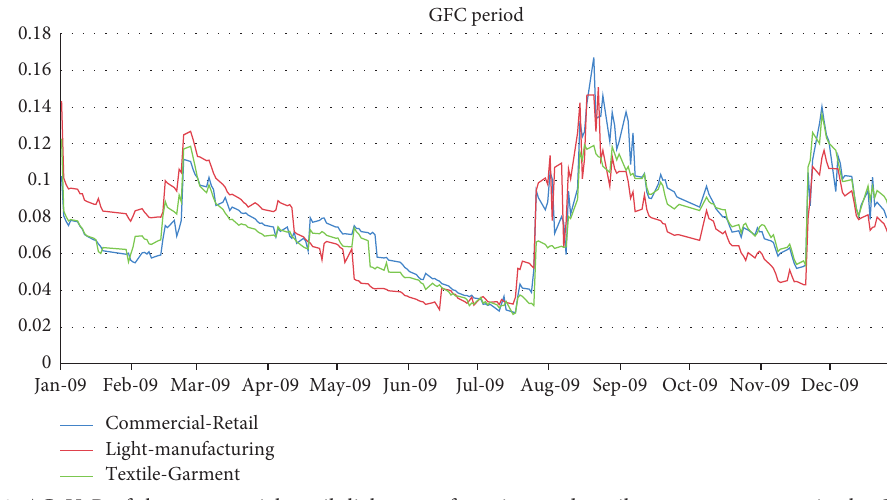
Figure 13: ∆ CoVaR of the commercial-retail, light manufacturing, and textiles-garments sectors in the GFC period.